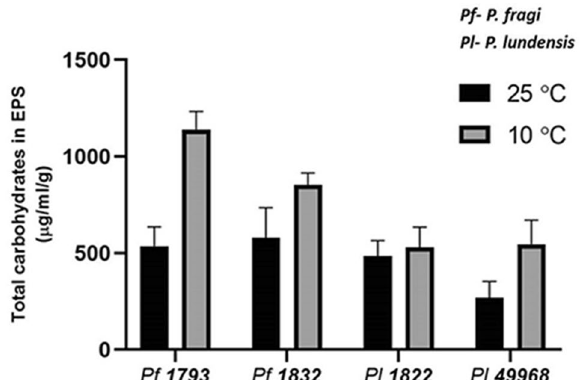
Figure 3. The total carbohydrate content of the matrix EPS. The carbohydrate content of soluble and bound fractions of extracted EPS of P. fragi (1793 and 1832) and P. lundensis (1822 and ATCC 49968) biofilms formed on nitro-cellulose membrane placed on meat at 10 °C and 25 °C.